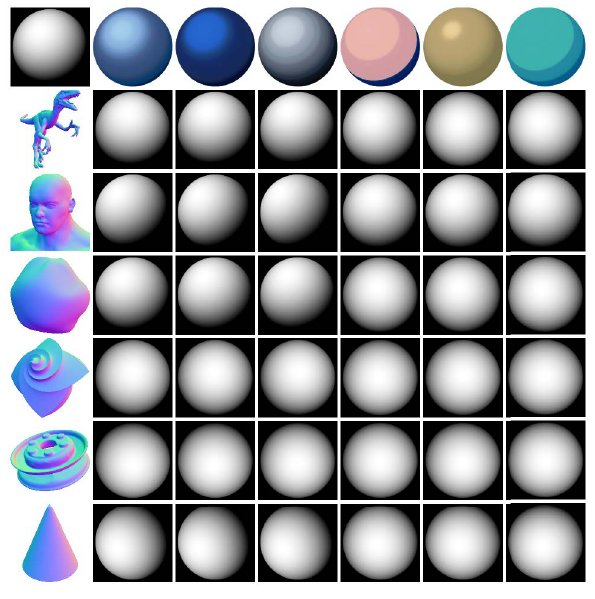
Fig. 20 Light estimation error. Top left: input ground-truth light direction L t . Top row: input color map materials shaded from the L t . The left 3 maps have small average errors; the right 3 maps have large average errors. Left column: input 3D models. The top 3 models have small average errors; the bottom 3 models have large average